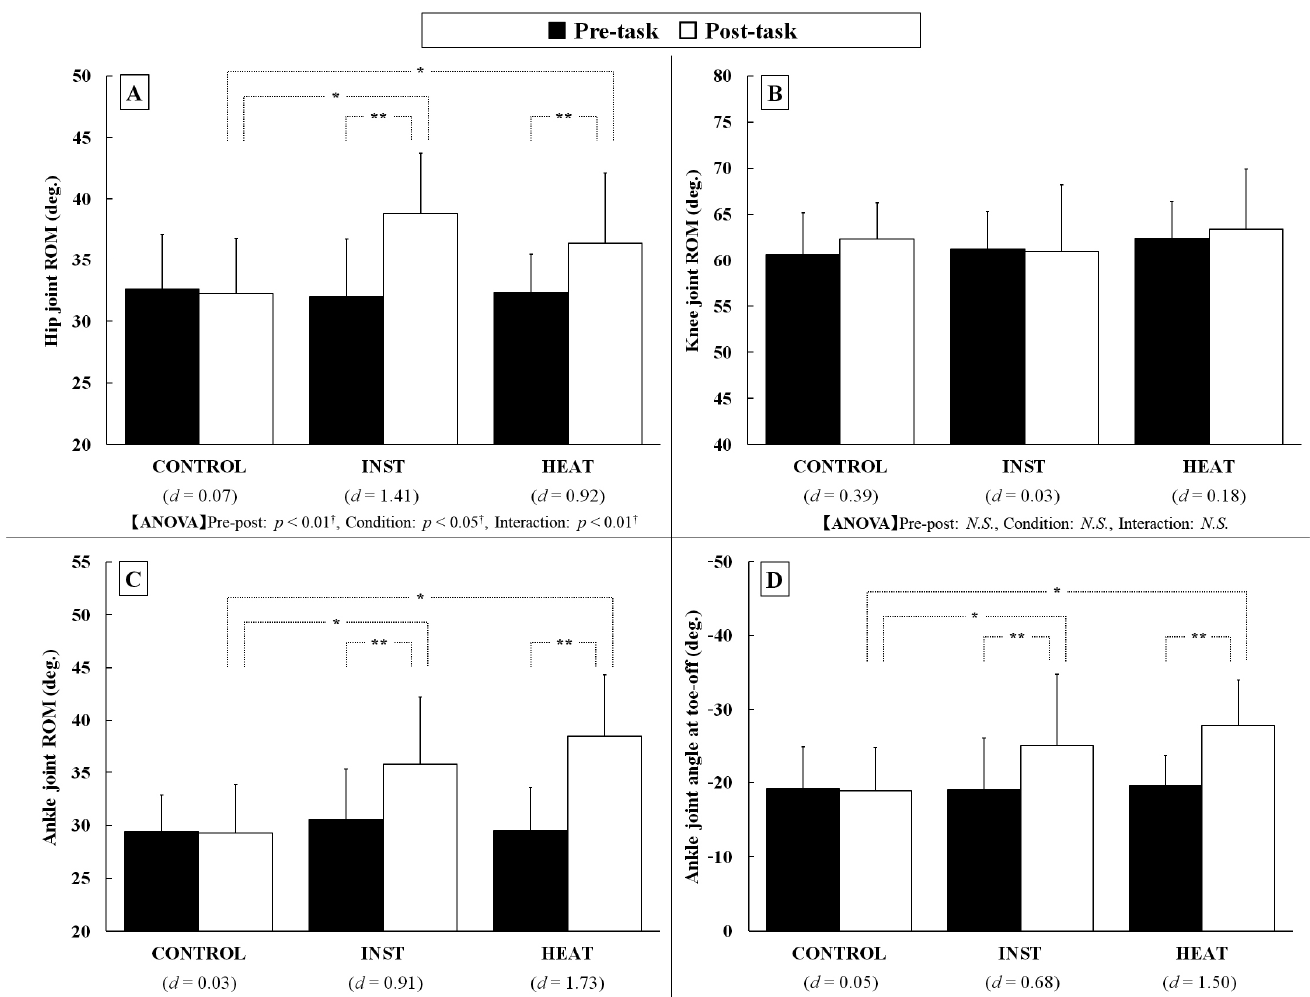
Figure 3. Hip ( A ), Knee ( B ), and ankle ( C ) joint ROM and ankle joint angle at heel-strike ( D ) during gait for the CONTROL, INST and HEAT condition (Values are means ± standard deviations. * and **: p < 0.05 and 0.01 (Holm’s multiple comparison). †: Statistical power (1 − β ) ≥ 0.80).